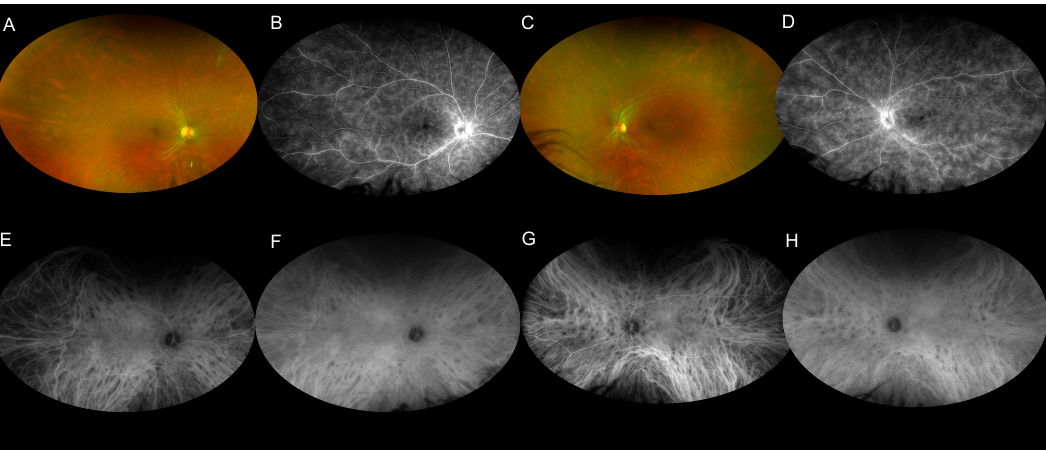
Figure 4. Multimodal imaging of a 30-year-old man with a recently diagnosed BSCR. ( A , C ) Wide-field color fundus photography shows subtle birdshot lesions inferonasally to the optic disc. ( B , D ) Late-phase wide-field fluorescein angiography illustrates hyperfuorescence of the optic disc and retinal veins in both eyes. ( E – H ) Wide-field indocyanine angiography (ICG-A) shows hypofluorescent spots consistent with birdshot lesions at the early-phase ( E , G ) and the mid-phase. The birdshot lesions are better seen on ICGA than on color fundus photography in this patient.